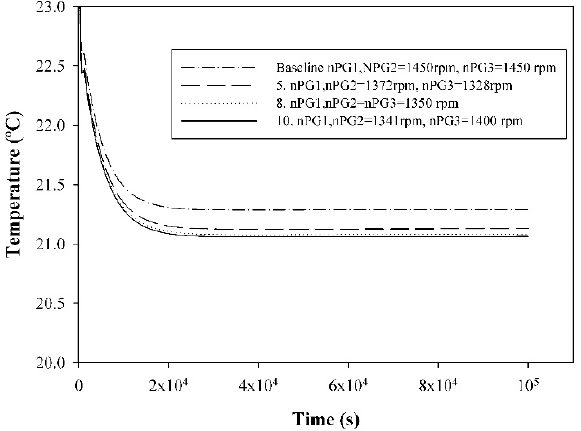
Figure 7. Influence of rotational speed of the pump motors on the water temperature of the cold water. Table 6. Scenarios for the variation of Cooling Tower Fans Rotational Speed.